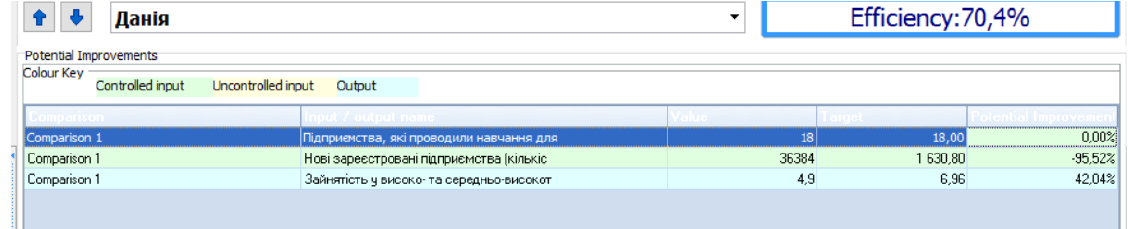
Figure 6. Country’s efficiency for